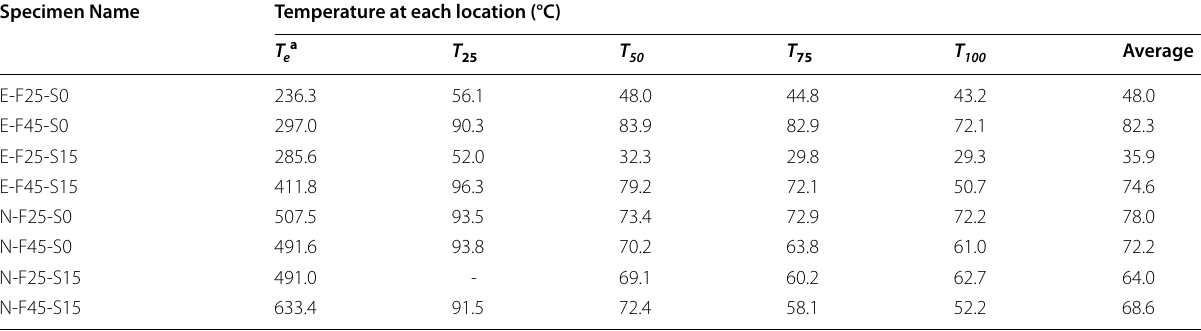
Table 6 Temperatures of thermocouples around epoxy when bond failure of FRP